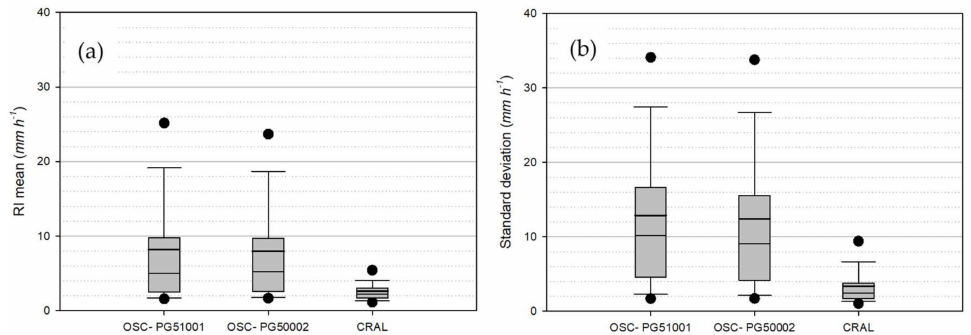
Figure 6. Non-parametric distribution of ( a ) the average value and ( b ) the standard deviation of the one-minute RI calculated for each precipitation event for the two OSC gauges and the CRAL gauge.